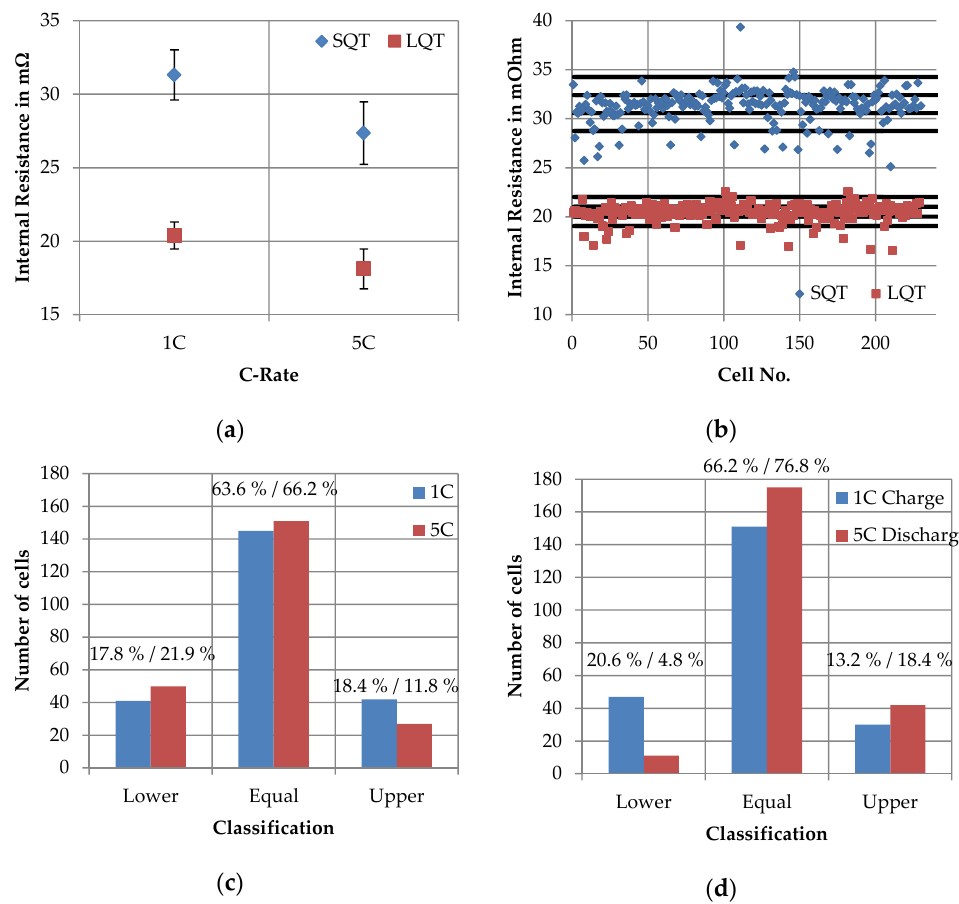
Figure 10. 1C and 5C internal resistance determined in short quality test (SQT) and long quality test (LQT) at a SoC level of 30%: ( a ) absolute values of the 1C and 5C internal resistance; ( b ) subdivision in values intervals using the example of the 1C internal resistance; ( c ) changes in the assignment of the cells to the value intervals for 1C and 5C internal resistances and ( d ) changes in the assignment of the cells to the value intervals for the average voltage of 1C charging step (C1 vs. C12) and the average voltage of the 5C discharging step (C1 vs.